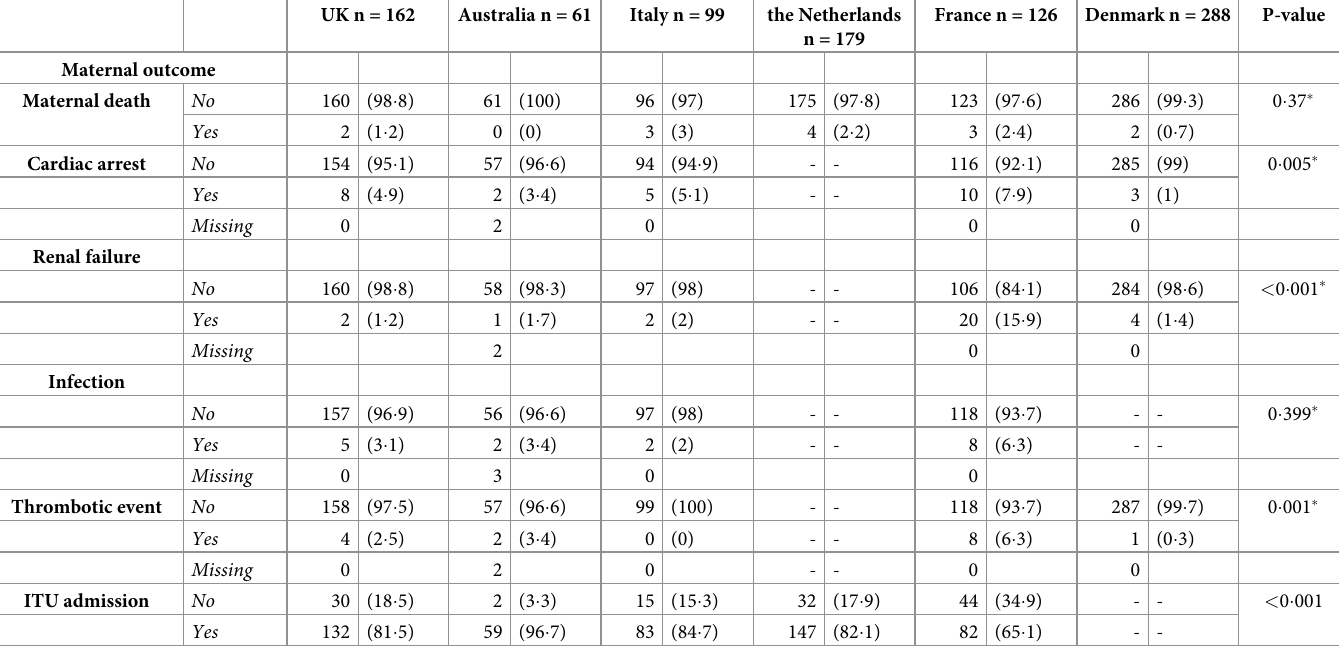
Table 5. Maternal outcomes by country.